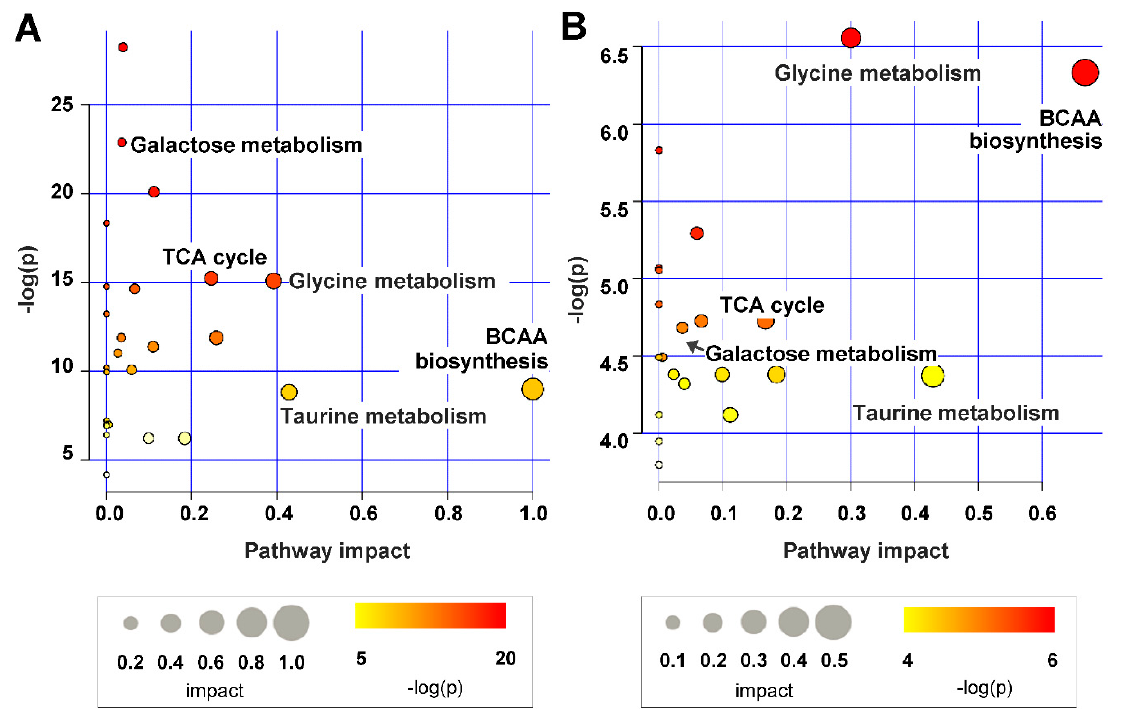
Figure 4. Summary of the analysis of pathways a ff ected by STZ-induced kidney injury ( A ) and losartan treatment ( B ) in urine. The circle size and importance ( x -axis) represent the pathway impact value calculated pathway topological analysis, and the circle color and direction ( y -axis) is the -log ( p -value) obtained from pathway enrichment analysis. The most significant pathways were represented with size and color in the circle from the smallest to the largest and from yellow to red, respectively.